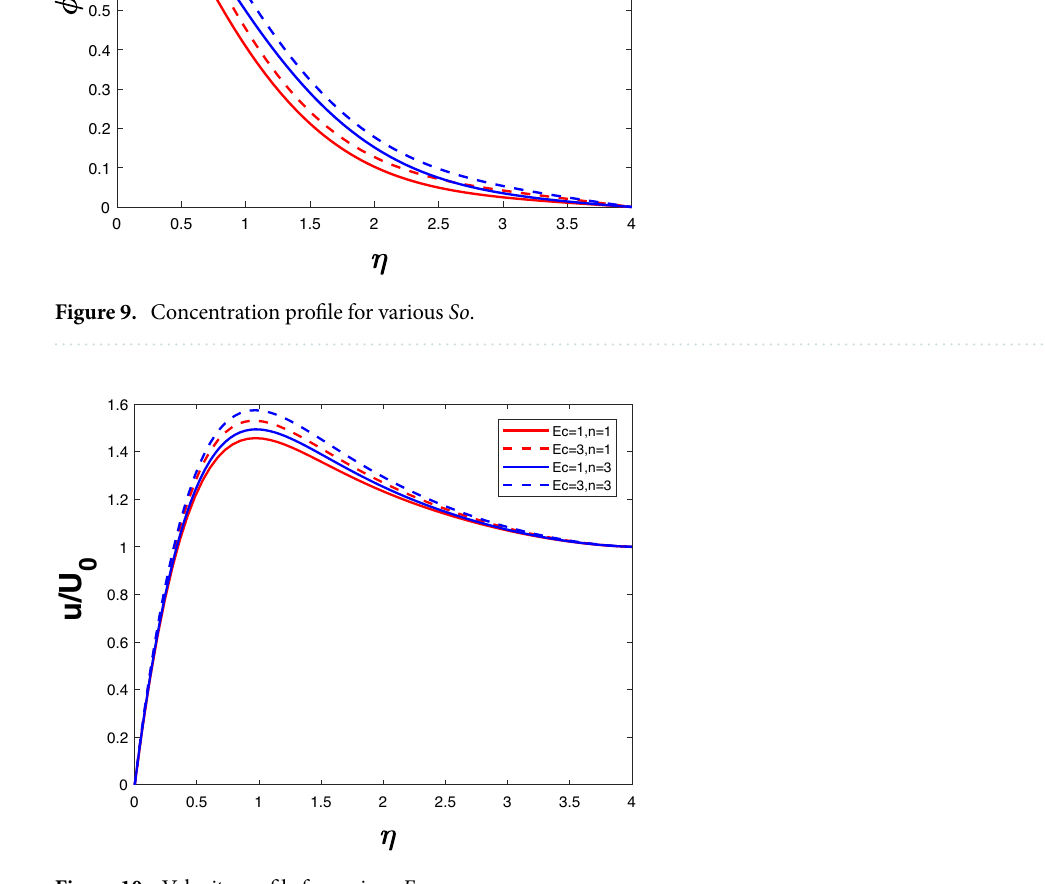
Figure 10. Velocity profile for various Ec